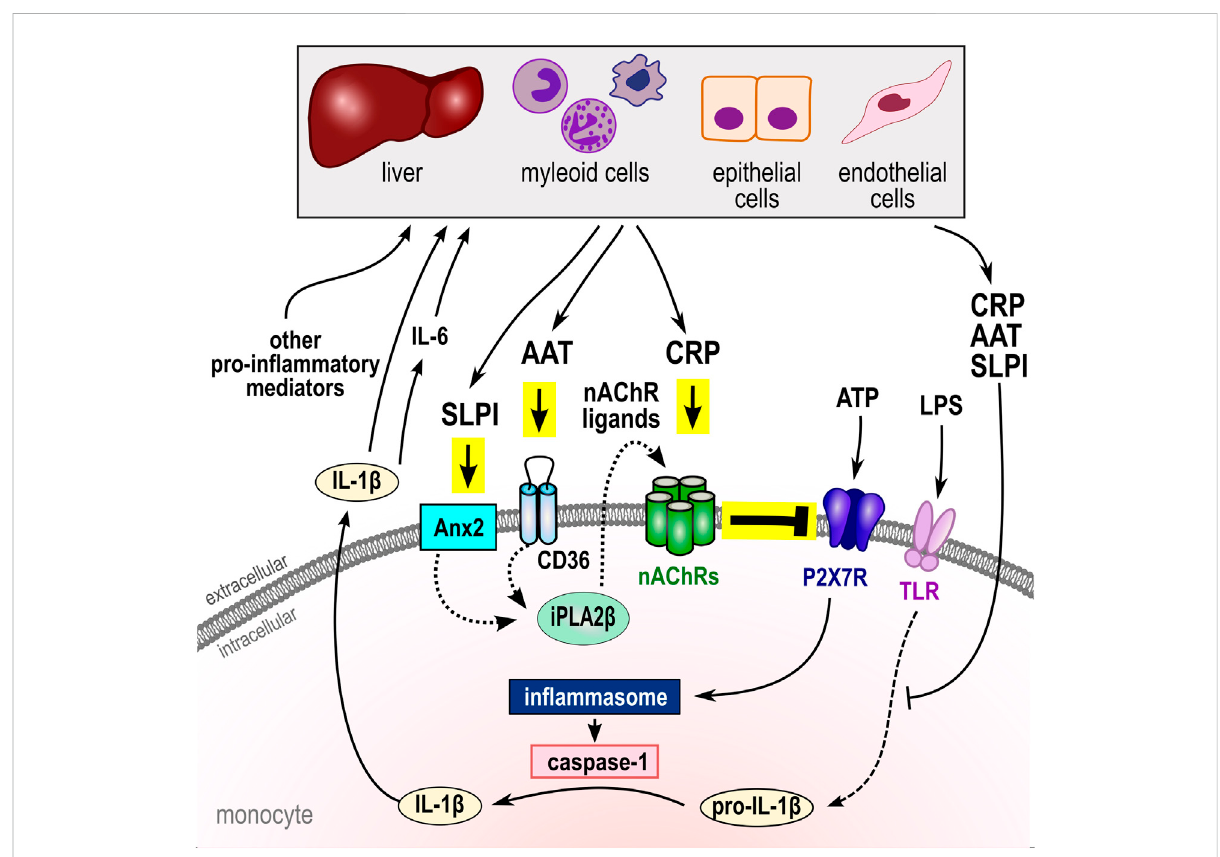
FIGURE 1 Negative regulation of ATP-induced NLRP3 in fl ammasome activation and cytokine secretion by the acute-phase proteins CRP, AAT, and SLPI. In monocytes, activation of the P2X7R by extracellular ATP results in the assembly of the NLRP3 in fl ammasome and activation of capspase-1 that cleaves pro-IL-1 β and enables its swift release. IL-1 β in turn induces IL-6 and both, like other pro-in fl ammatory mediators, activate the synthesis of theacutephase proteins CRP,AAT andSLPI byhepatic, myeloid,epithelial,and endothelial cells. Thereisgrowingevidence, thatCRP, AAT,and SLPI can control the biosynthesis, maturation, and secretion of pro-in fl ammatory cytokines by controlling cytokine expression levels. Moreover, these acute-phase proteins can control the ATP-induced in fl ammasome activation and IL-1 β release by activation of unconventional monocytic nAChRs containing subunits α 7, α 9and/or α 10 thatinhibittheionotropic functionoftheP2X7R. DifferentnAChRsubunitsinteract, depending onthe respective nicotinic agonist (see Table 1). While CRP directly activates nAChRs, AAT (via CD36) and SLPI (via Anx2) activate iPLA2 β and induce the release of ligand(s) of nAChRs with yet unknown structure. In summary, apart from other functions, CRP, AAT, and SLPI seem to be central elements of systemic negative feedback loops that protect the host against systemic hyperin fl ammation, barrier dysfunction, and death by multiple organ damage. AAT, α 1-antitrypsin; Anx2, annexin 2 (ANXA2); CRP, native pentameric C-reactive protein; IL, interleukin; LPS, lipopolysaccharide; nAChRs, nicotinicacetylcholinereceptor(CHRNA);NLRP3,NACHT,LRR,andPYDdomains-containingprotein3;SLPI,secretoryleukocyteproteaseinhibitor; P2X7R, ATP receptor P2X7; iPLA2 β , calcium-independent phospholipase A2 β (PLA2G6); TLR, Toll-like